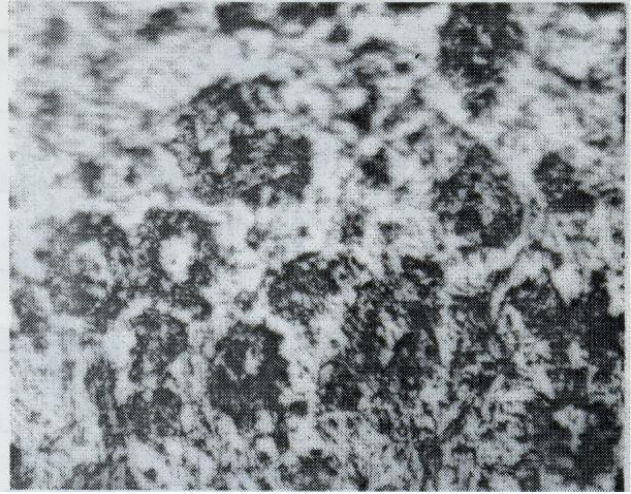
Figure 6. Velocity heterogenization of shock-loaded polycrystalline copper.(after Yano K., Horie Y-Y).